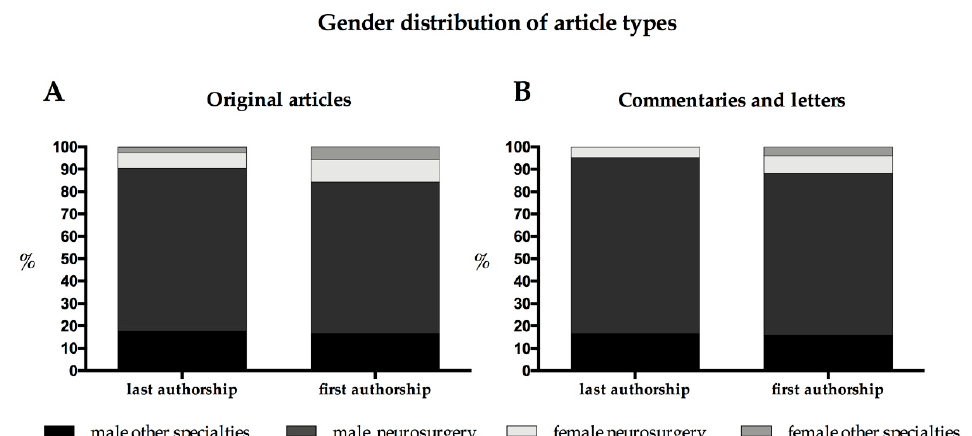
Figure 2. Gender distribution with regard to article type distinguishing authors affiliated to a neurosurgical department and those not affiliated to a neurosurgical department; ( A ) original articles; ( B ) commentaries and letters.